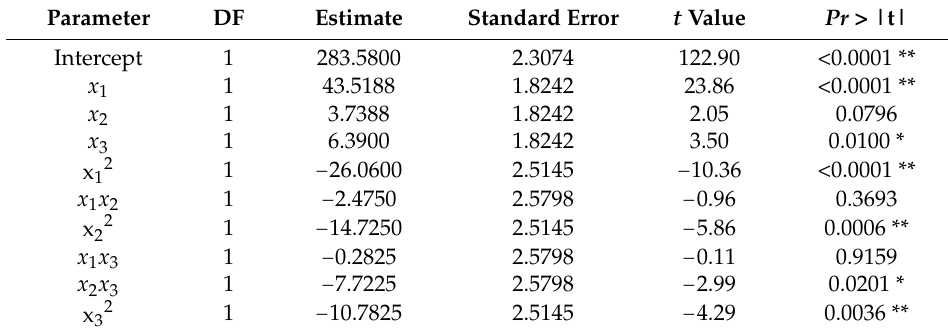
Table 5. Analysis of variance (ANOVA) for all factors for optimization of TA production by G. lingzhi .